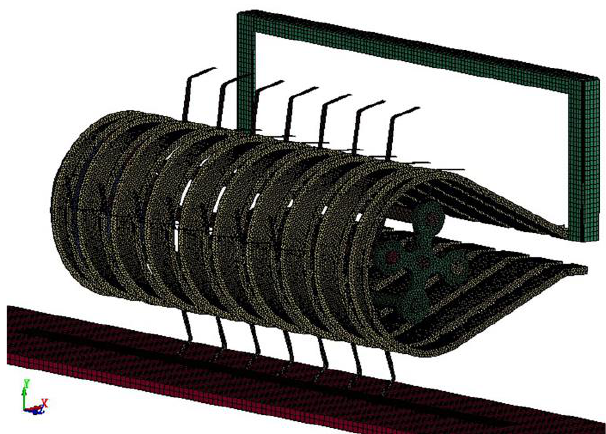
Figure 4. Finite element model of picking system.